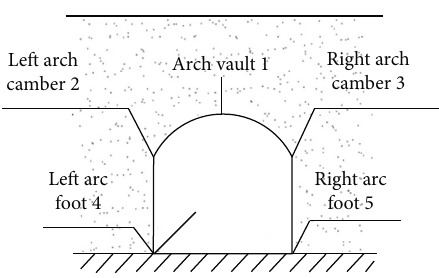
Figure 6: The locations of fi ve key points in of horizontal displacement time-history occurs when t = 2 : 22 s; the curve peak of horizontal acceleration time- history occurs when t = 2 : 18 s. The larger displacement value and acceleration value are mainly concentrated in 2.0-6.0 s.